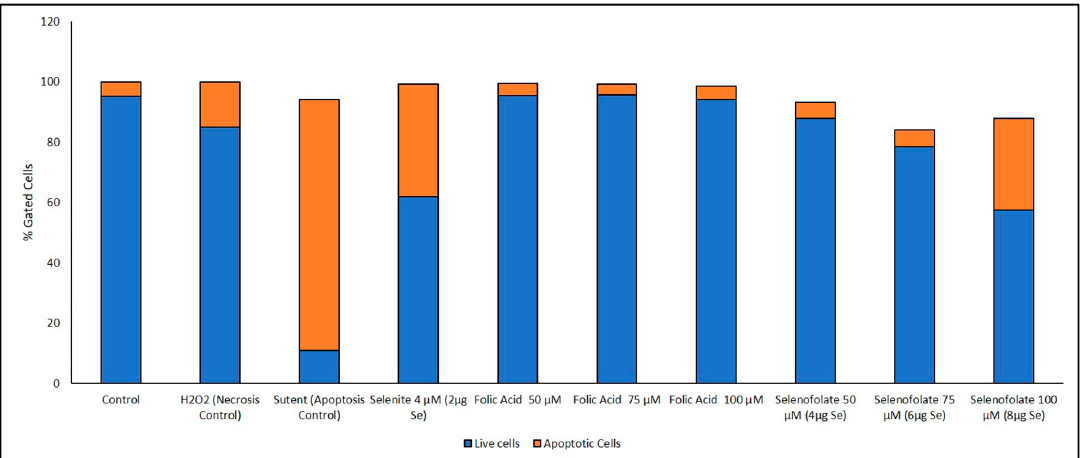
Figure 11. Graphical representation (as percent cells) of apoptotic events following Selenofolate treatment. Percent distribution of HME50-5E apoptotic cells after treatment with H 2 O 2 (necrosis inducer), Sutent (apoptosis inducer), selenite (positive control), Folic Acid and Selenofolate treatments, or untreated. Data are expressed as the ean ( n = 3) and is based upon 100% of cells gated. Interestingly, Sutent demonstrated even greater potency in killing the normal cells (Figure